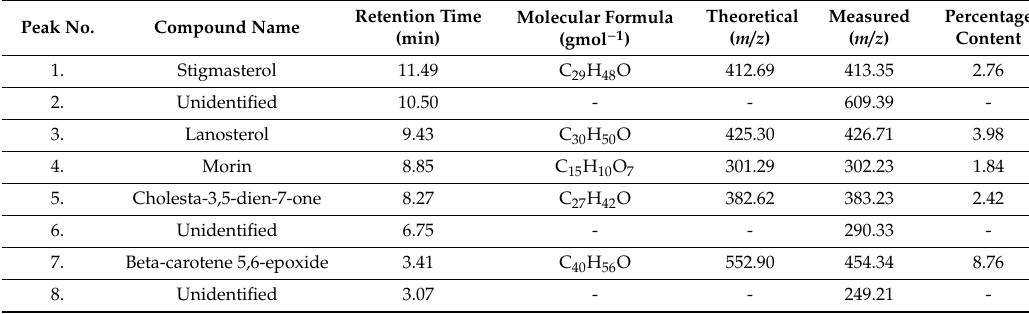
Table 3. The major components found in the AME extract based on LC-MS analysis. Peak